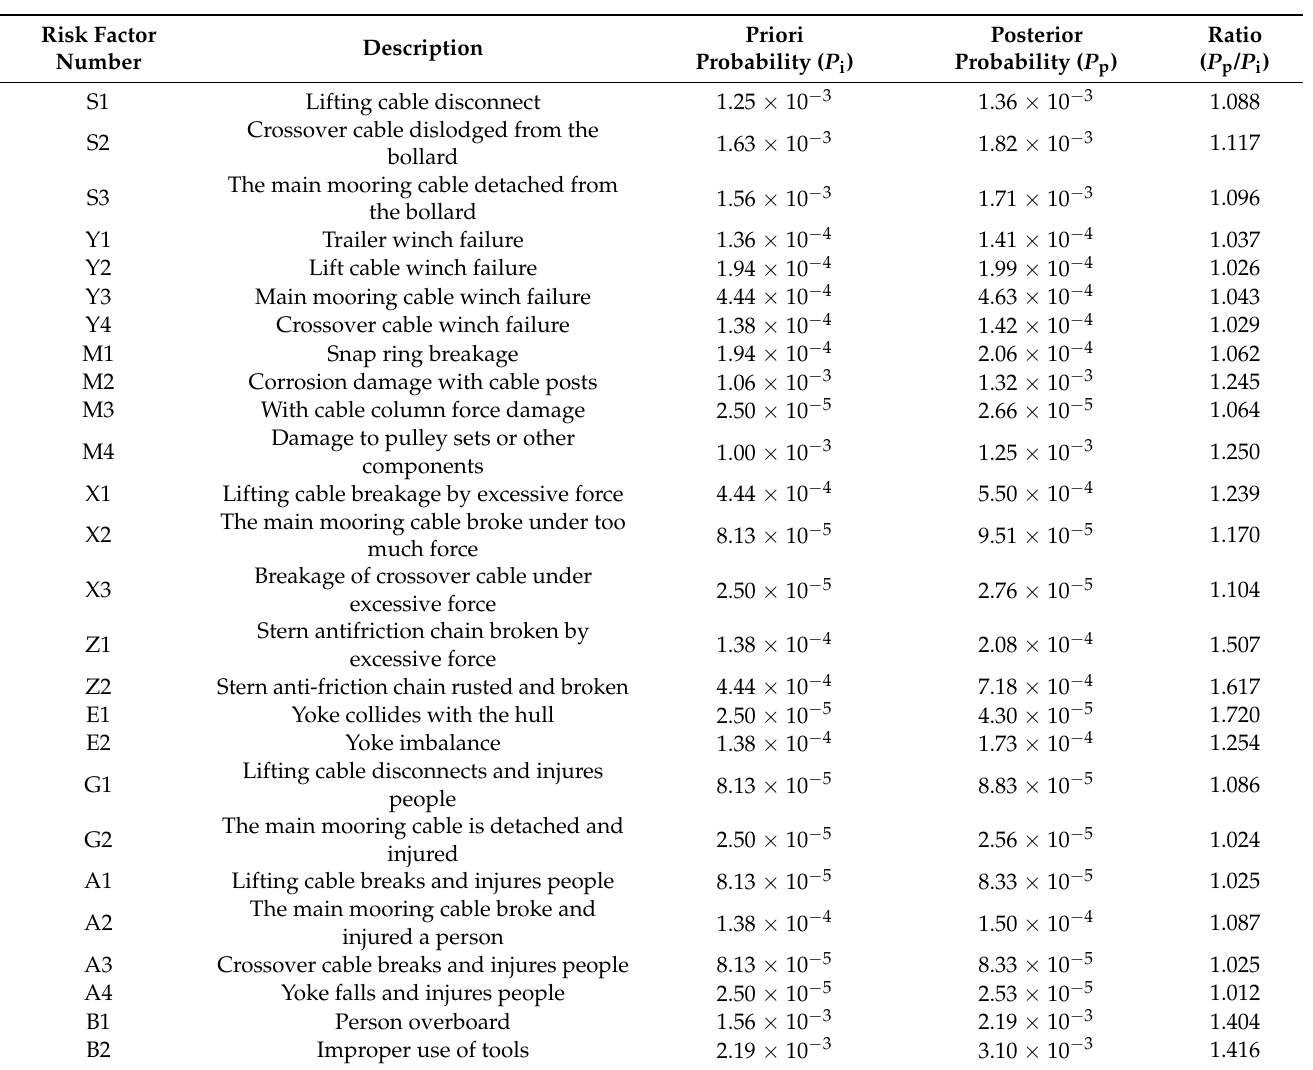
Table 9. A priori probabilities of risk